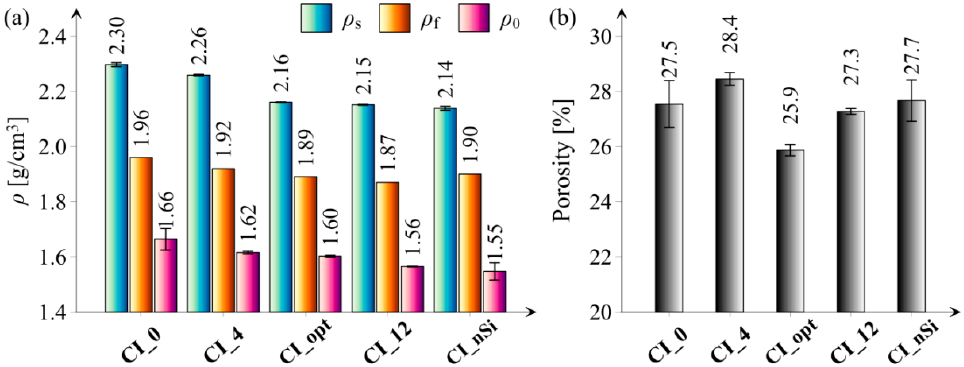
Figure 7. Results of physical properties of hardened cement paste of all tested series: ( a ) specific density ( ρ s ), fresh paste density ( ρ f ), and bulk density ( ρ o ), ( b ) porosity. Vertical bars indicate one standard deviation.